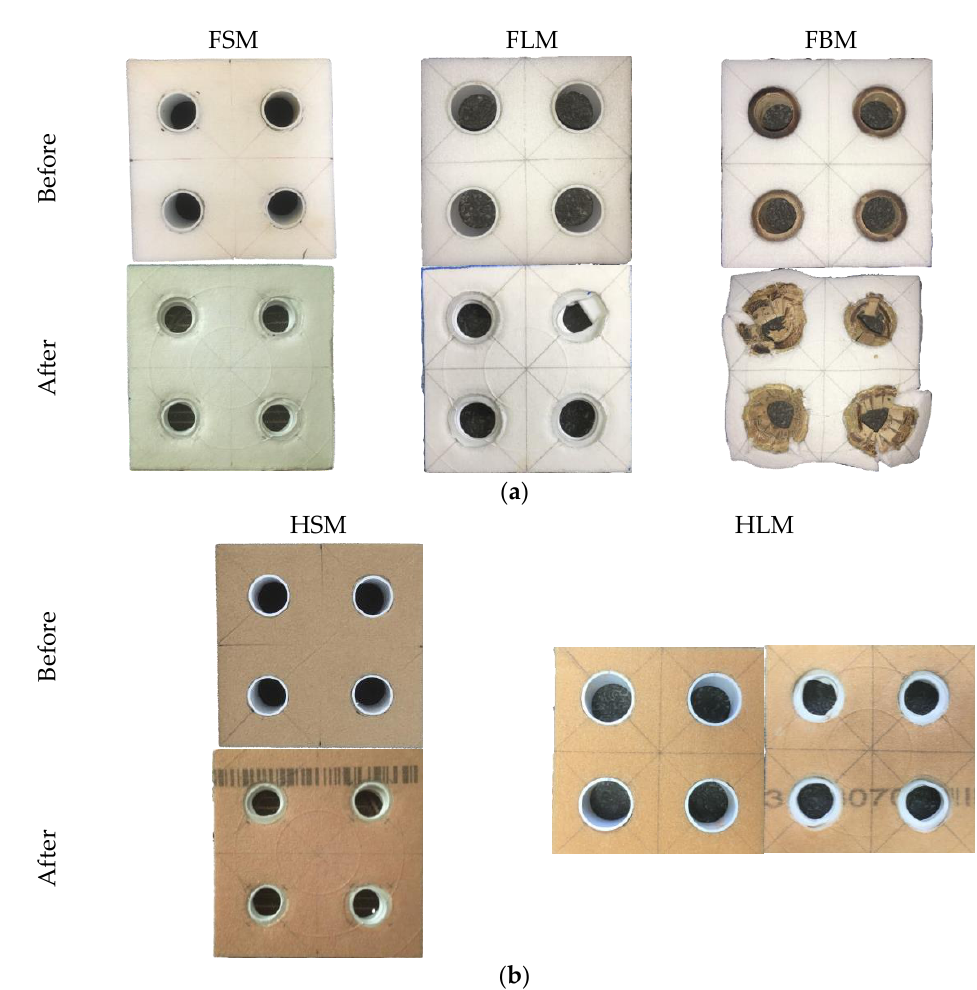
Figure 12. The top view of multiple tube structure with ( a ) F50 and ( b ) HP80 foam strucctures.